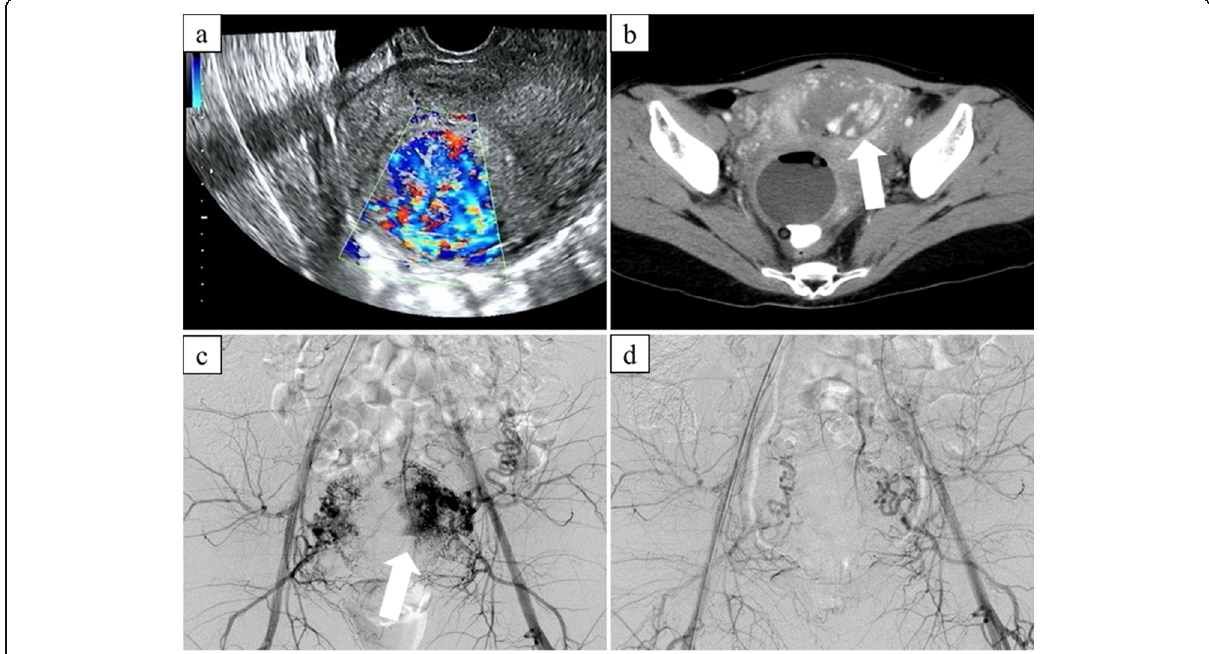
Fig. 1 31-year-old patient with vaginal bleeding after vaginal delivery. a Transvaginal ultrasonography showing a hypervascular hyperechoic mass in the endometrium. b Arterial-phase contrast enhanced CT showing focal enhancement (arrow) within the endometrium. c Aortography showing numerous spiral arteries and a focal blush in the left side of uterus (arrow). d Post-embolization aortography showing contrast stasis without focal blush